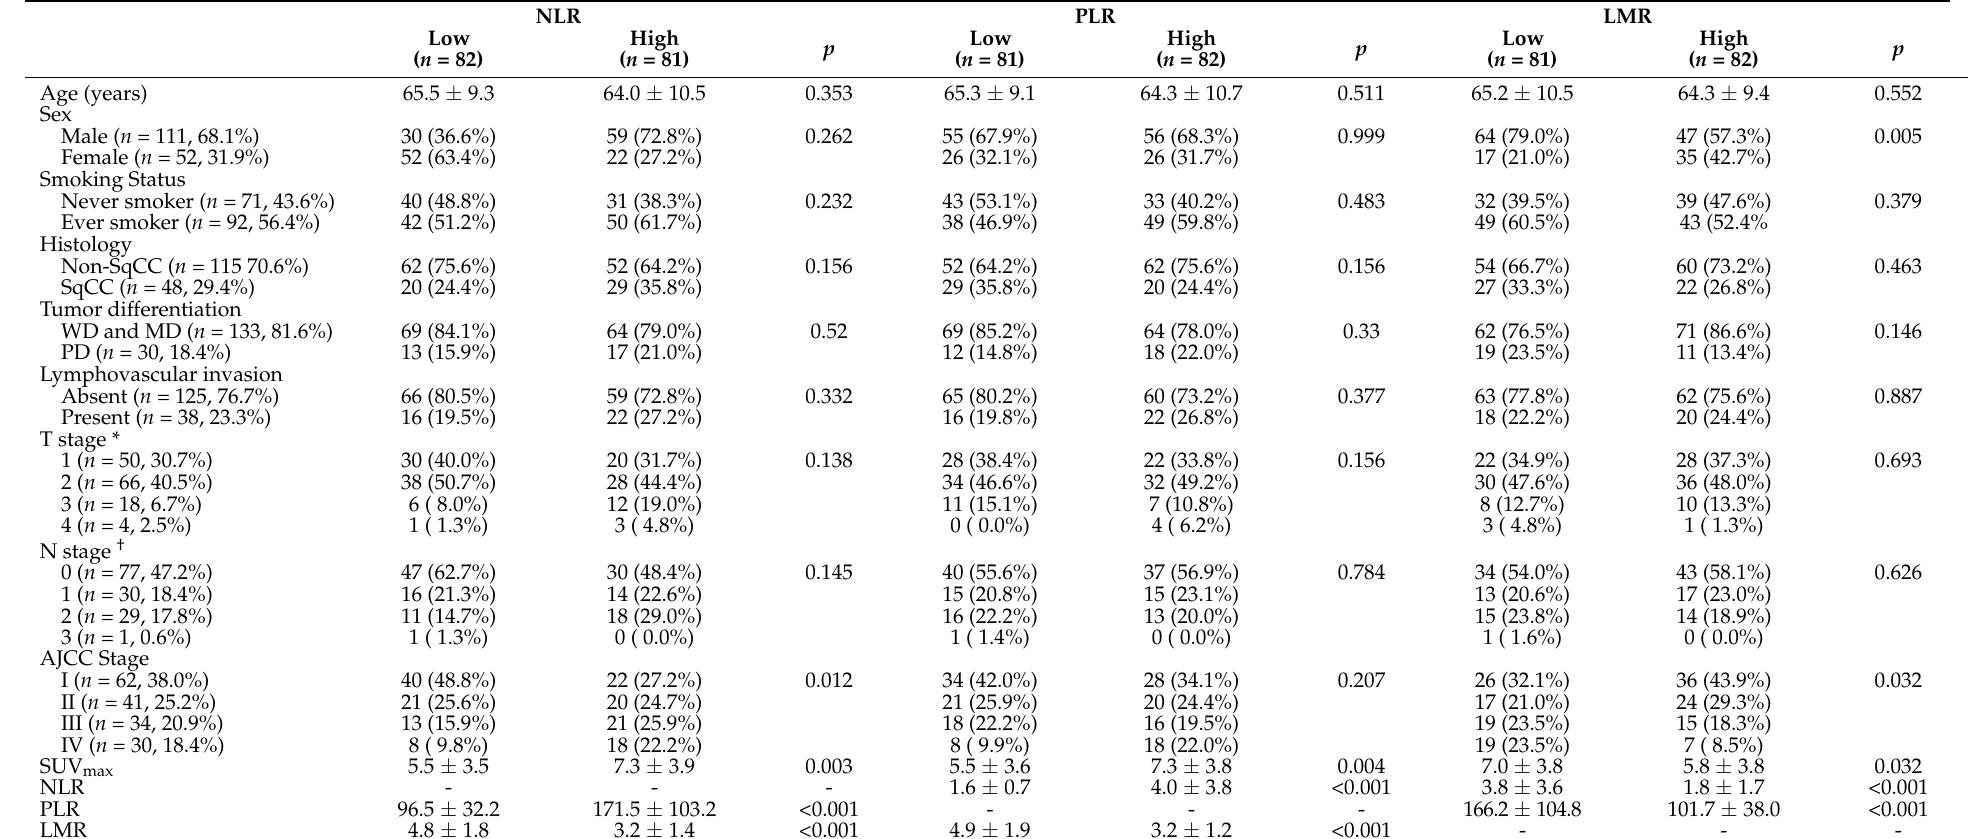
Table 2. Relationship between systemic inflammatory markers and clinicopathologic features in patients with non-small cell lung